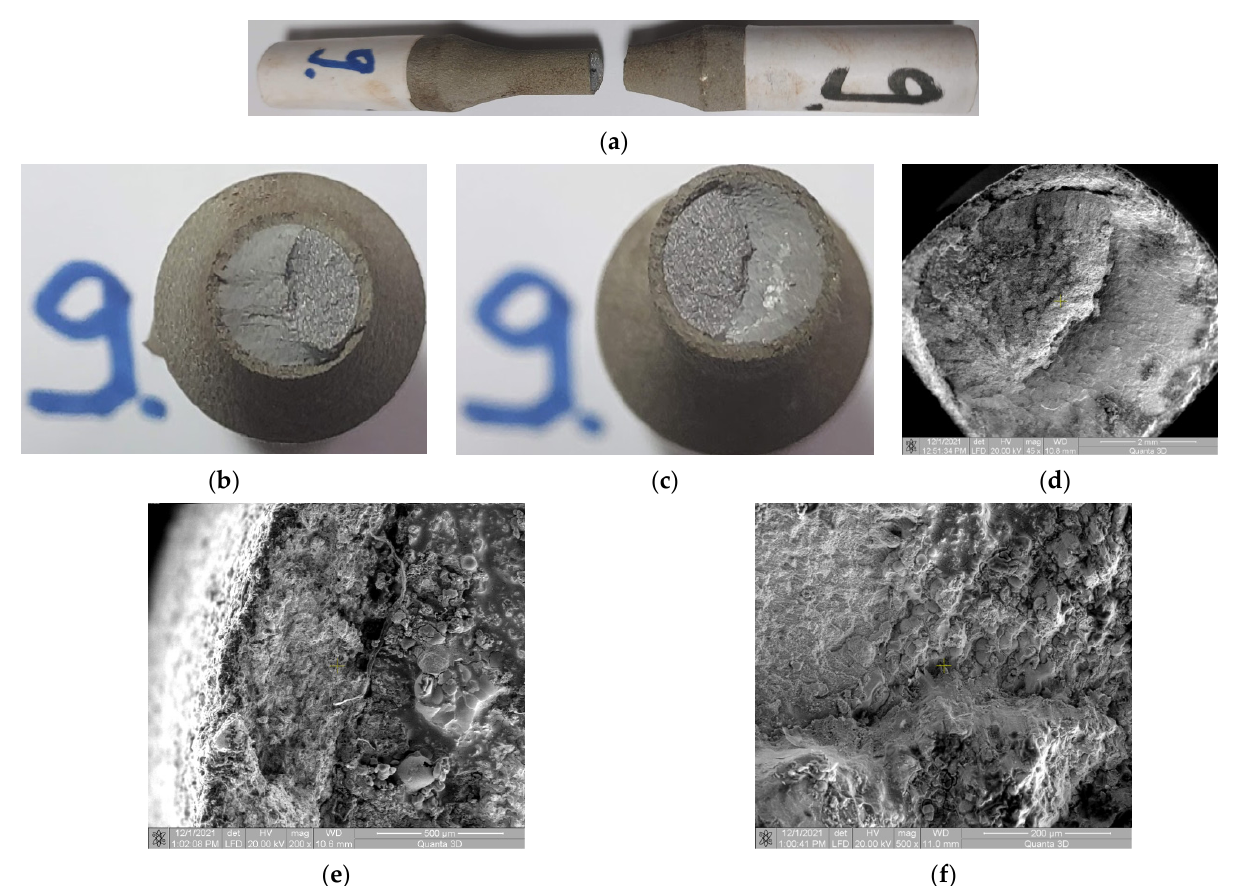
Figure 13. Macroscopic and microscopic appearance of broken surfaces for Sample 9, σ max = 446 MPa, N = 4,424,120 cycles. ( a ) Sample 9 broken by fatigue. ( b , c ) Image of fractured surfaces. ( d ) SEM image of the fracture surface at 42× magnification. ( e , f ) SEM images of the area where a crack initiated with 200×, and 500× magnification.